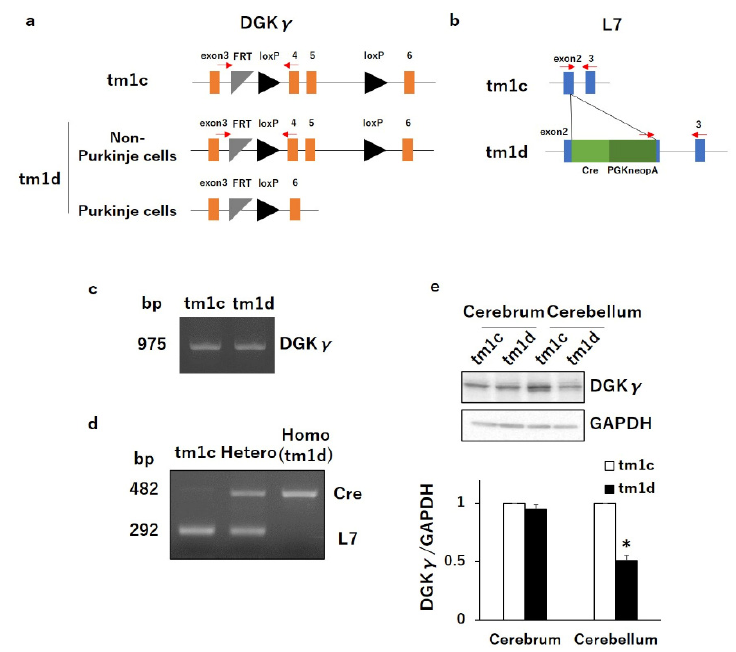
Figure 1. Generation of Purkinje cell-specific Diacylglycerol kinase γ (DGK γ ) knockout (KO) (tm1d) mice and PCR genotyping: tm1c and tm1d alleles encodes DGK γ ( a ) and Cre recombinase knock-in L7 ( b ). Cre, Cre recombinase; FRT, flippase recognition target; loxP, Cre recombinase recognition sequence; PGKneopA, PGK-neomycin cassette. PCR genotyping of DGK γ gene ( c ) and Cre recombinase ( d ) was determined using tail-derived genome: bands at 975, 482, and 292 bp were expected for the DGK γ , Cre, and L7 alleles, respectively. Red arrows show the primer sites for PCR genotyping. ( e ) Cerebral and cerebellar lysates from tm1c and tm1d mice were subjected to Western blotting and probed with an anti-DGK γ antibody. Quantification of the expression levels of DGK γ was performed by ImageJ. The expression level of DGK γ was normalized to the expression level of the loading control (Glyceraldehyde 3-phosphate dehydrogenase: GAPDH). (n = 3); * p < 0.05, followed by Student’s t-test. Data are expressed as mean ± SEM.